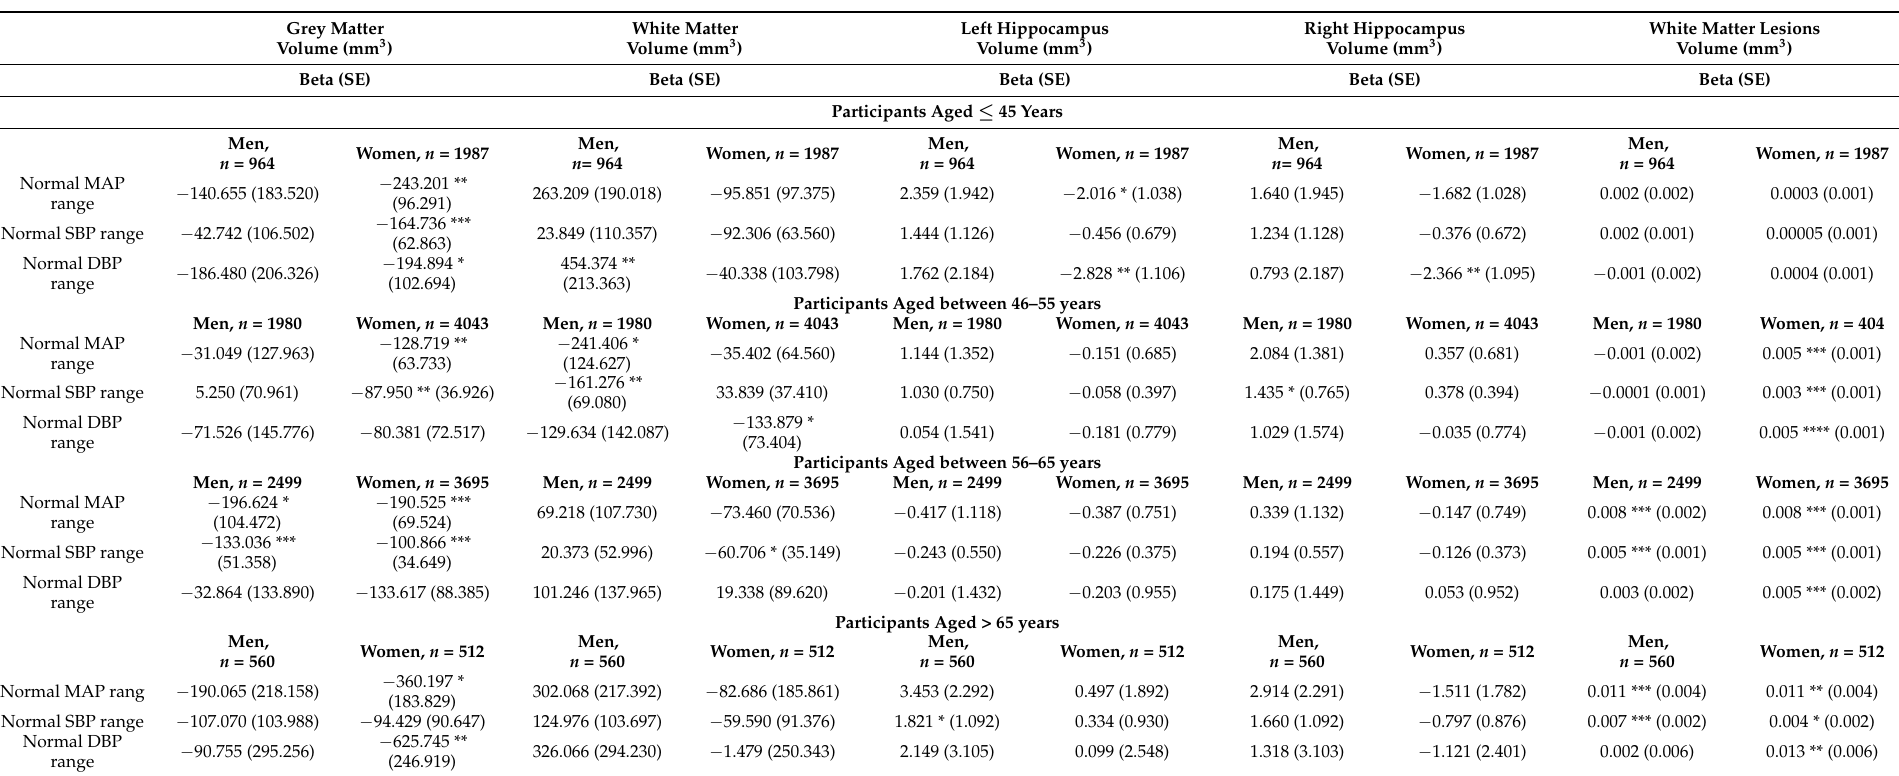
Table 4. Association between baseline normal BP including MAP, SBP, and DBP level and brain volumes across age groups in men and women at UK biobank